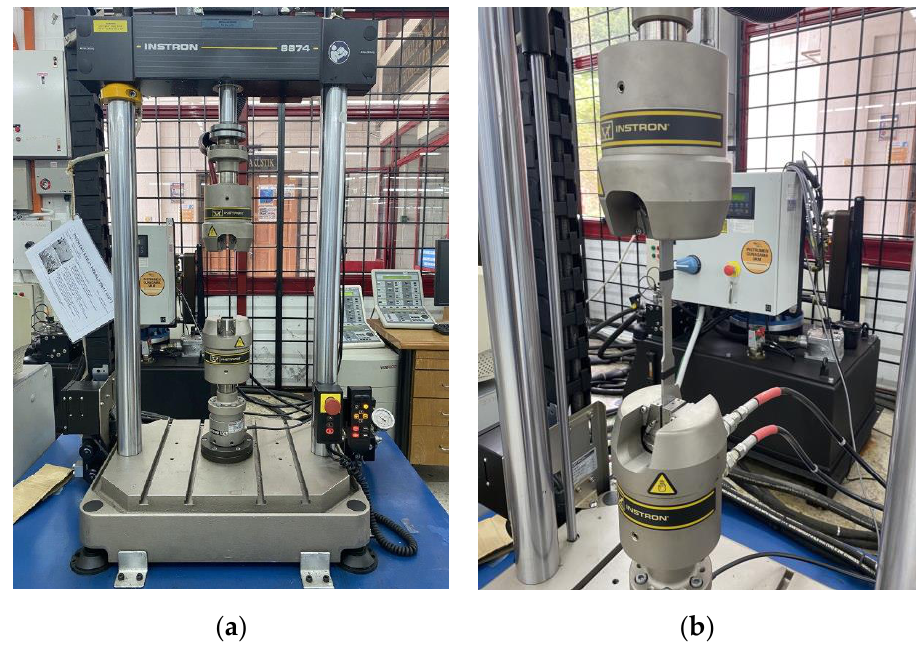
Figure 5. Specimen set-up for the cyclic test; ( a ) 25 kN servo-hydraulic machine, ( b ) ASTM E466 standard specimen equipped onto jigs of the machine. Table 2. Load design for the cyclic test based on UTS percentage.